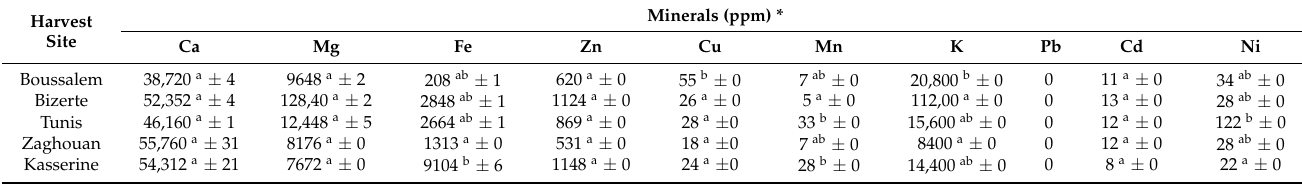
Table 5. Mineral contents in M. vulgare